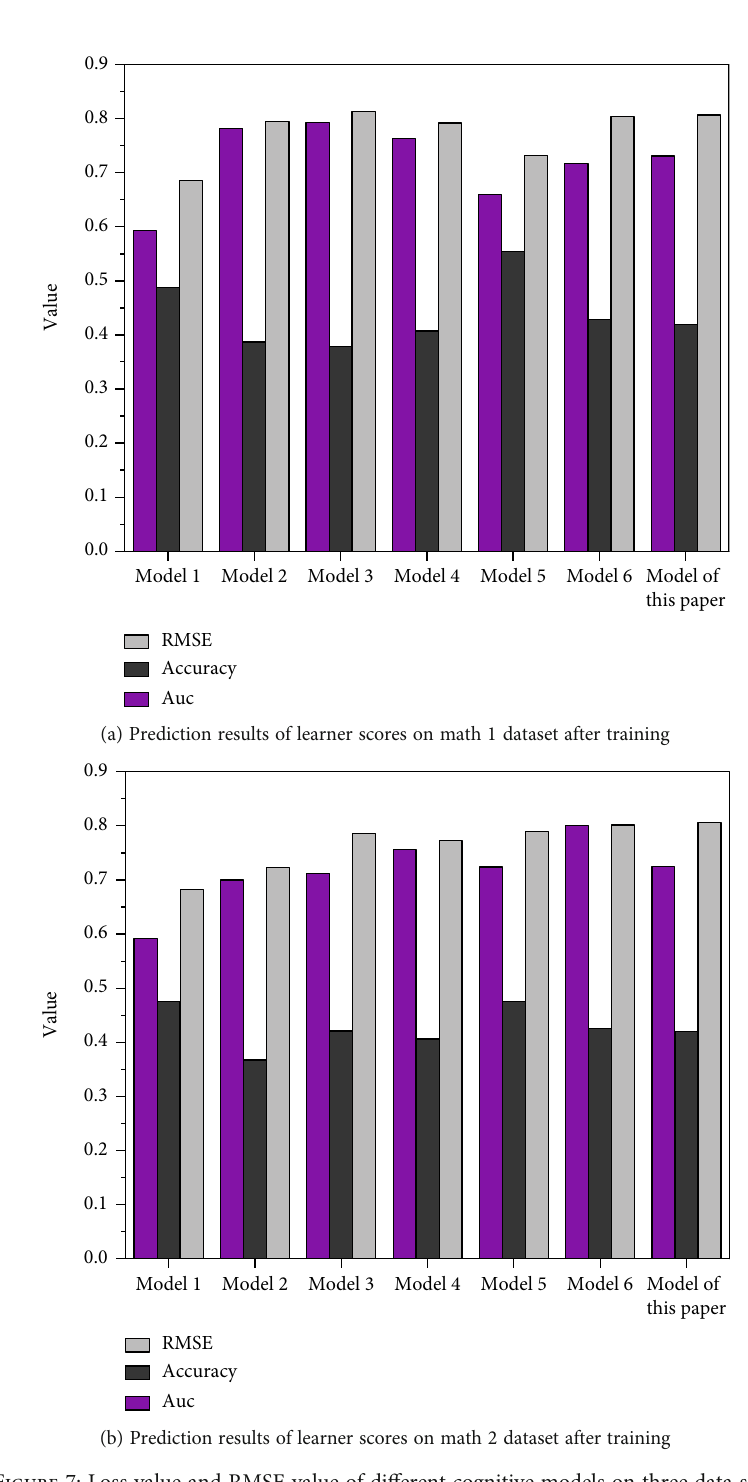
Figure 7: Loss value and RMSE value of di ff erent cognitive models on three data